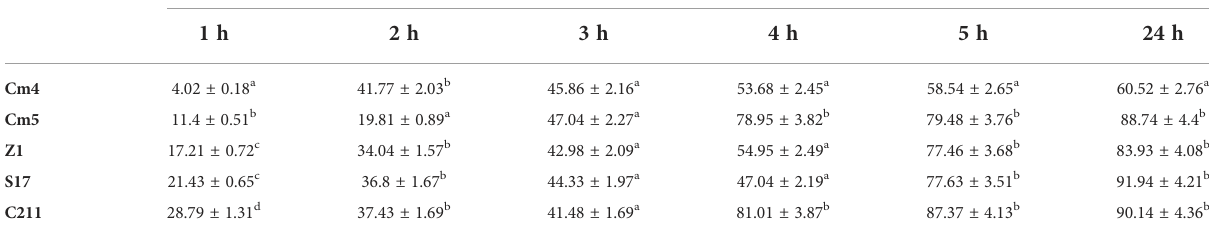
TABLE 4 Auto-aggregation of the isolate strains after 24